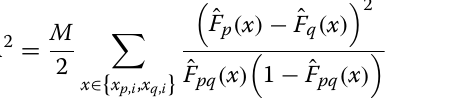
for the Sentinel-1 data to avoid unconnected SAR images. Figure 4a ‒ c show the networks for the ALOS-2 and ascending and descending Sentinel-1 images, respectively.